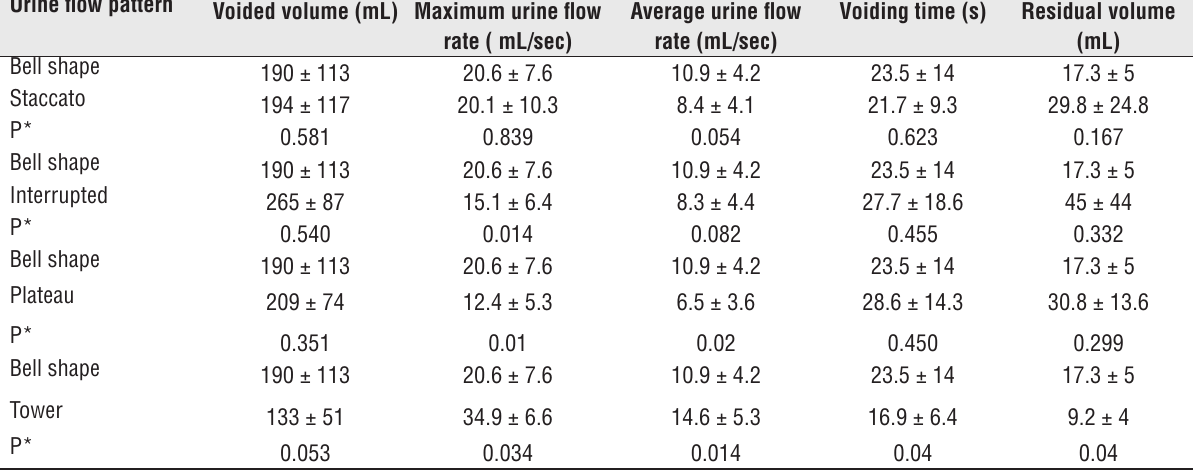
Table 2 - Comparison of uroflowmetry measures and post-void residual volume between patients with normal and abnormal urine flow patterns.